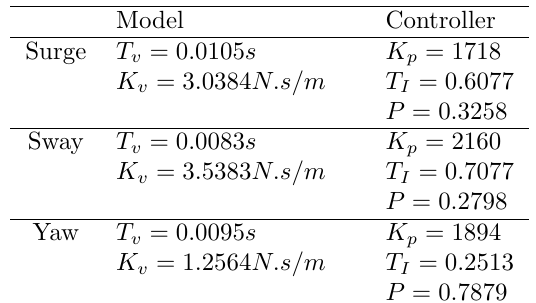
Table 1: Model and controller parameters Model